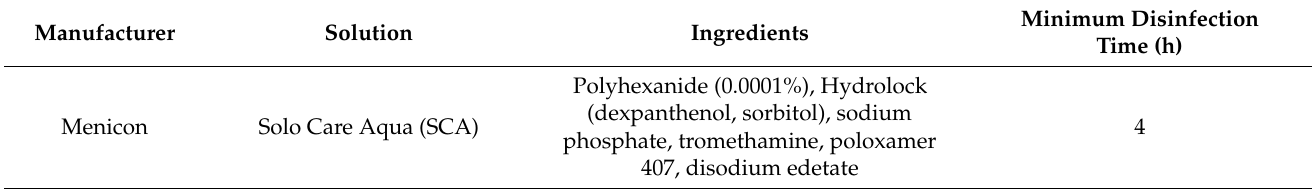
Table 1. Composition of the multipurpose contact lens solutions and minimum disinfection times recommended by the